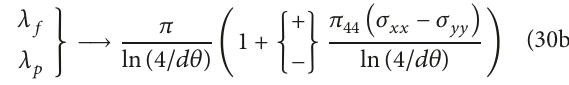
whereby we used 𝐿(𝑥) → 1/ cosh 2 (𝜋𝑥/2 − ln 2) for large 𝑥 (see [10]) and we made a series in the small stress terms.